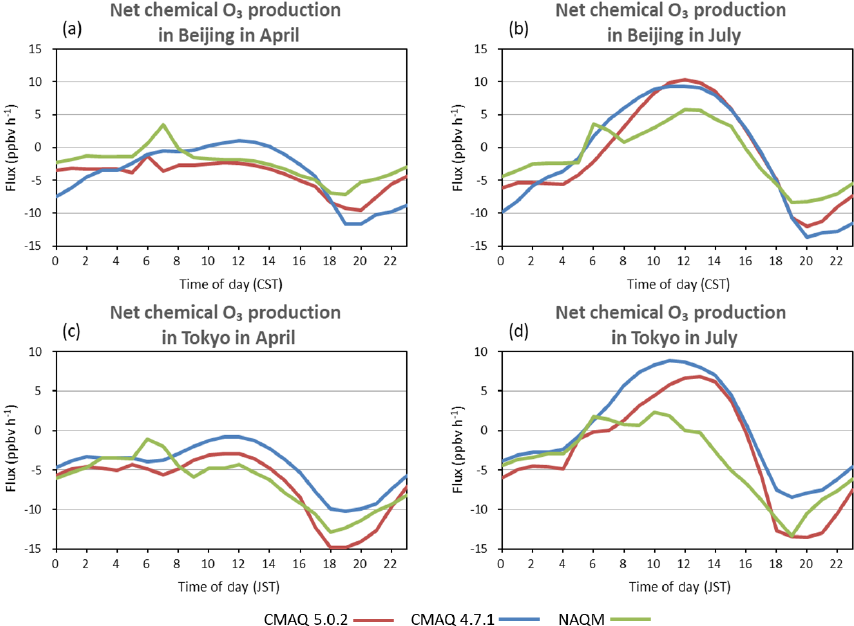
Figure 5. Comparison of net chemical O 3 production in (a) Beijing in April, (b) Beijing in July, (c) Tokyo in April, and (d) Tokyo in